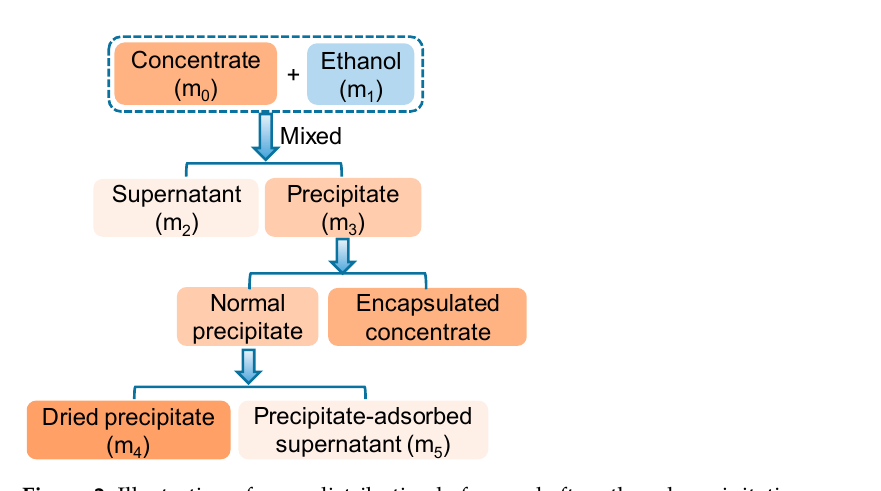
Figure 2. Illustration of mass distribution before and after ethanol precipitation.